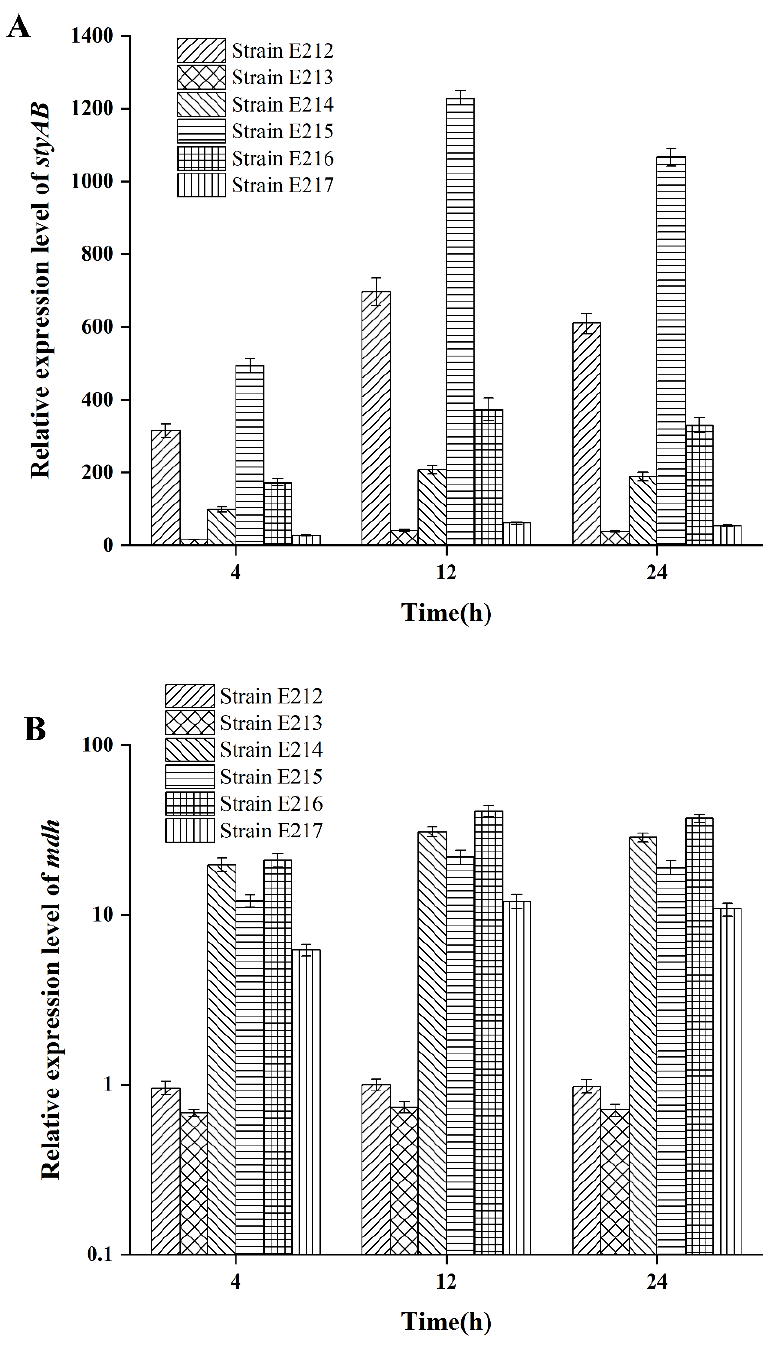
Figure 3. Transcriptional level assay of the genes styAB and mdh in recombinant strains cultured under fermentation conditions with 2.0 g/L of tryptophan as substrate after 4 h, 12 h and 24 h. ( A ) Expression level of styAB gene. ( B ) Expression level of mdh